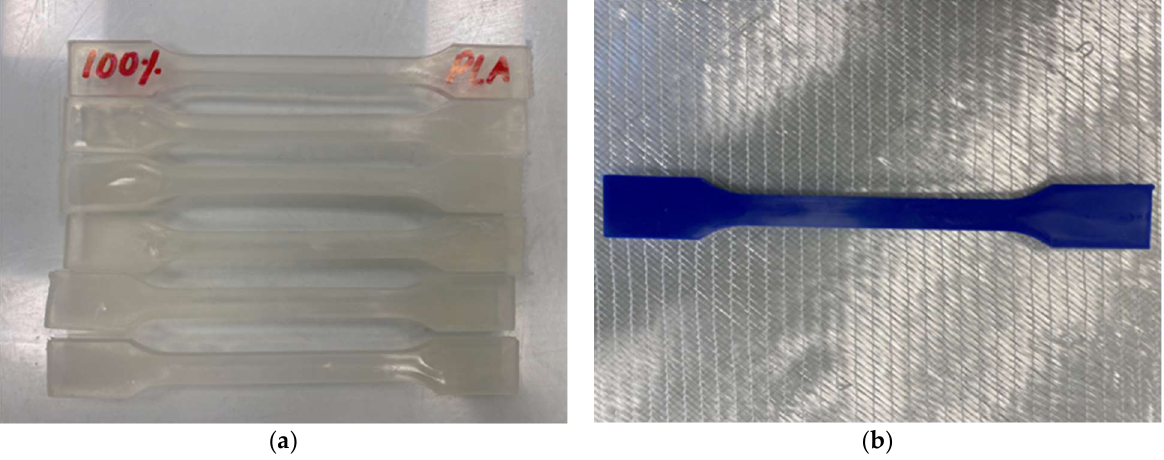
Figure 1. Injection molded dog bone-shaped specimens of: ( a ) Neat PLA; ( b ) PLA plasticized with 5% of EPSO.